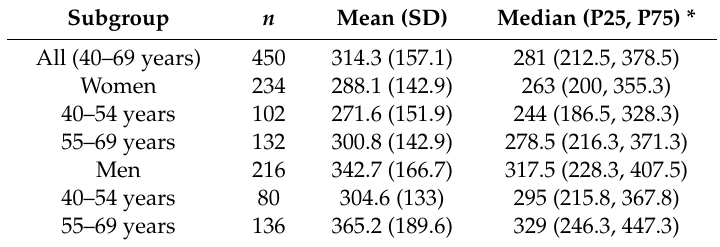
Table 3. Estimated daily habitual iodine intake ( µ g / day) from food frequency questionnaire in